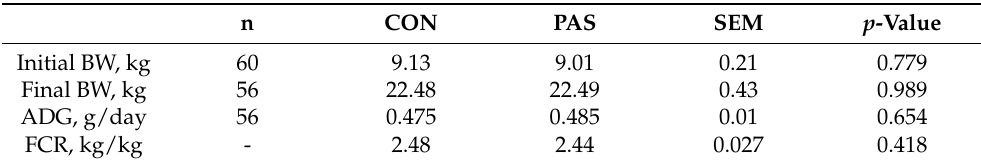
Table 2. Growth performance of piglets fed the control diet (CON) or diet supplemented with Passiflora incarnata powder extract (PAS) standardized for vitexin. n